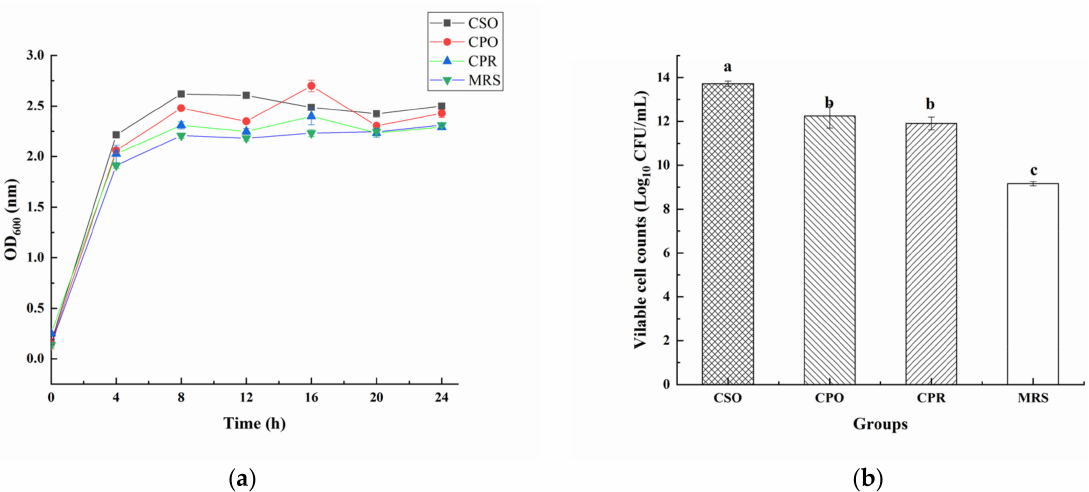
Figure 2. The effect of coix seed extract (CSE) on the growth of L. reuteri ( a ) and the count of viable bacteria in the stable phase ( b ). Values are presented as mean ± standard deviation ( n = 3). Different letters indicate statistical differences between groups ( p <